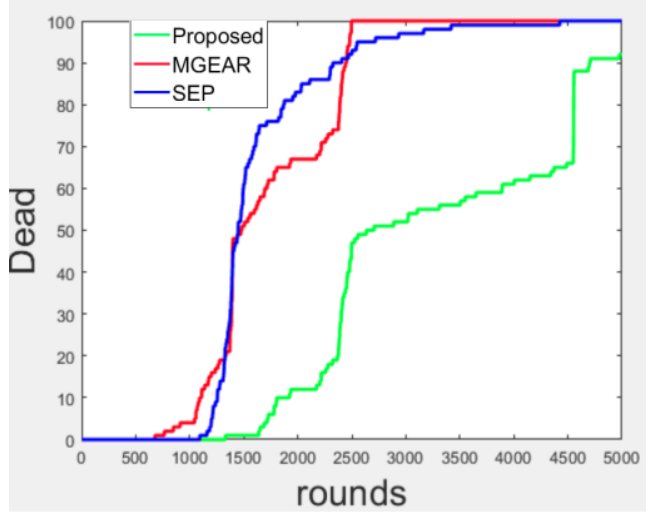
Figure 3. Number of dead nodes per round.